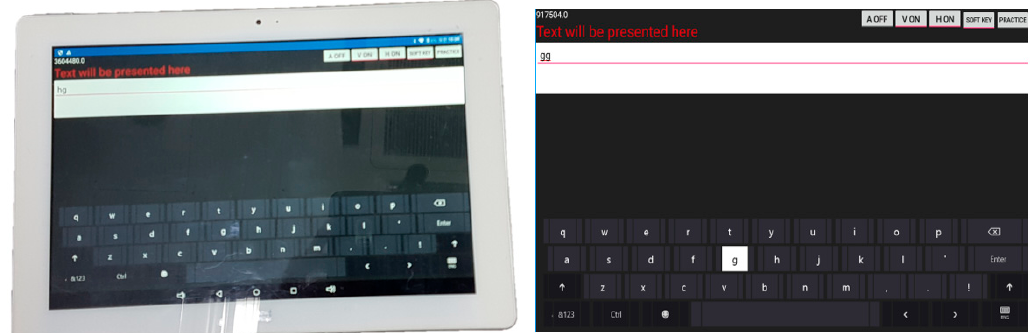
Figure 9. Soft keyboard design and a user interface implemented on the Android platform with a 10.1 inch commercial touchscreen (uPad) for a user study. The white text field was an area for a user to transcribe a red sentence randomly selected from a test set of sentences created by [23]. For the visual (V) condition, the pressed key was highlighted in white, while tactile key click feedback was additionally provided for the visual and haptic (VH) condition.